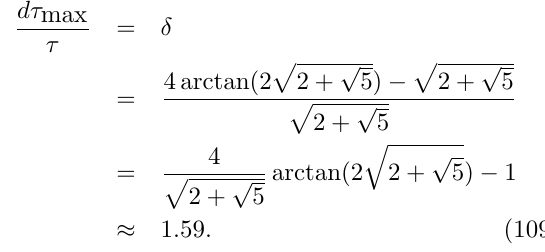
Table 2: Recommended settings for the parameter ¯ c when one wants to minimize the indices M s , IAE v , ITAE v , IAE , ITAE r and IAE r , re- spectively. A good trade of between